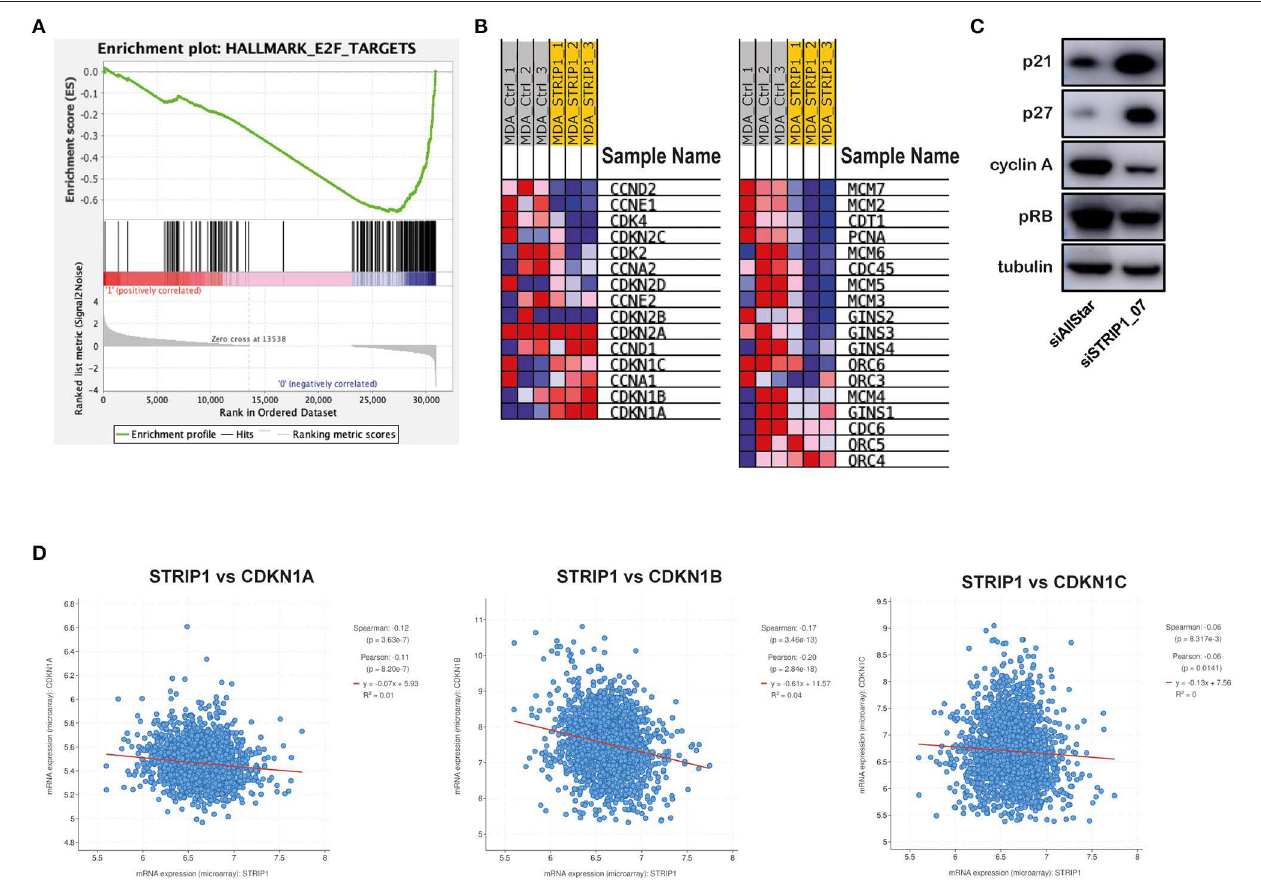
FIGURE 2 | Loss of STRIP1 induces expression of CDK inhibitors p21 and p27. (A) Gene Set Enrichment Analysis of RNA-sequencing data of siRNA-depleted MDA-MB-231 cells. The data shows an overall reduction in E2F targeted genes after loss of STRIP1 in MDA-MB-231 cells. (B) Heat map of selected genes involved in the regulation of cell cycle progression in control and STRIP1 siRNA-depleted cells. (C) Immunoblotting analysis of cell cycle regulating proteins p21, p27, Cyclin-A, pRB. Expression of p21 and p27 are enhanced upon STRIP1 loss while Cyclin-A and pRB are depleted upon STRIP1 loss. All immunoblotting analyses were conducted at least three independent times. (D) Dataset analysis showing negative correlation of STRIP1 to CDK inhibitors CDKN1A, CDKN1B, and CDKN1C.